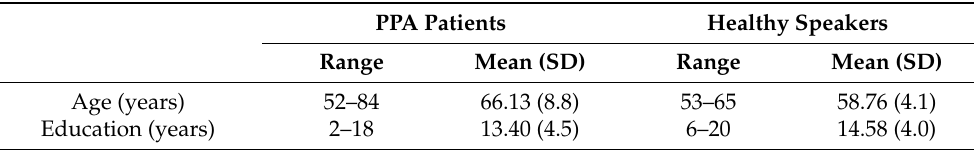
Table 1. Demographic characteristics of the participants. PPA Patients Healthy